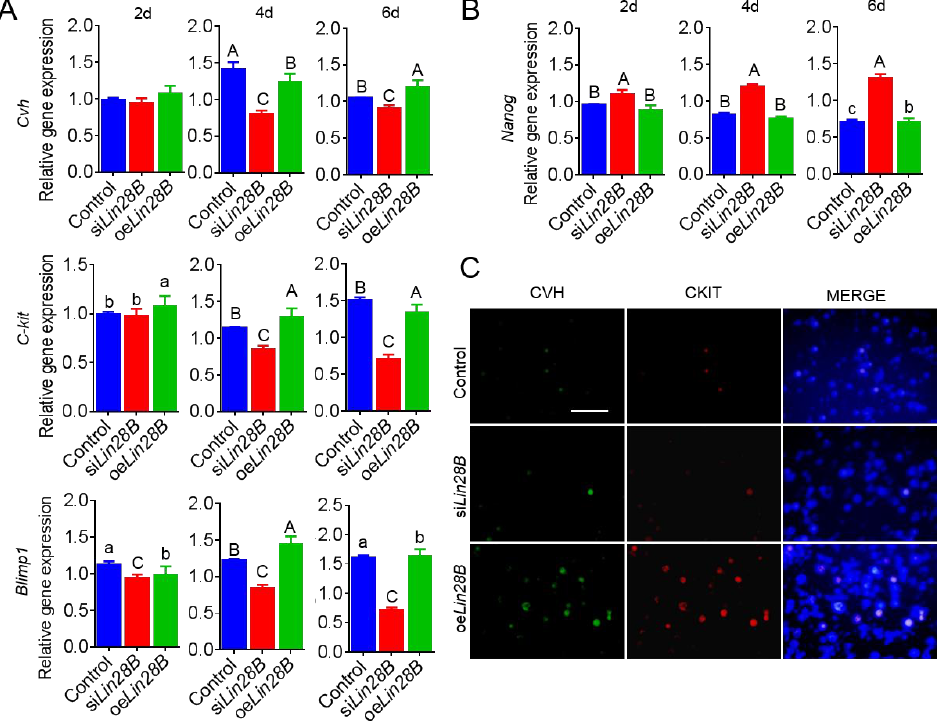
Figure 7. Lin28B could positively modulate the formation of PGCs in BMP4-induced model in vitro. ( A , B ) qRT-PCR was used to detect the expression of NANOG , Cvh , Ckit , and Blimp1 during the induction of PGCs in vitro . Different uppercase letters represent highly significant, different lowercase letters represent significant, and the same letters represent no significant. ( C ) Indirect immunofluorescence detection of the efficiency of the formation of PGCs at day 6 in the induced model after treatment with different Lin28B in vitro . Scale bar: 60 μm.